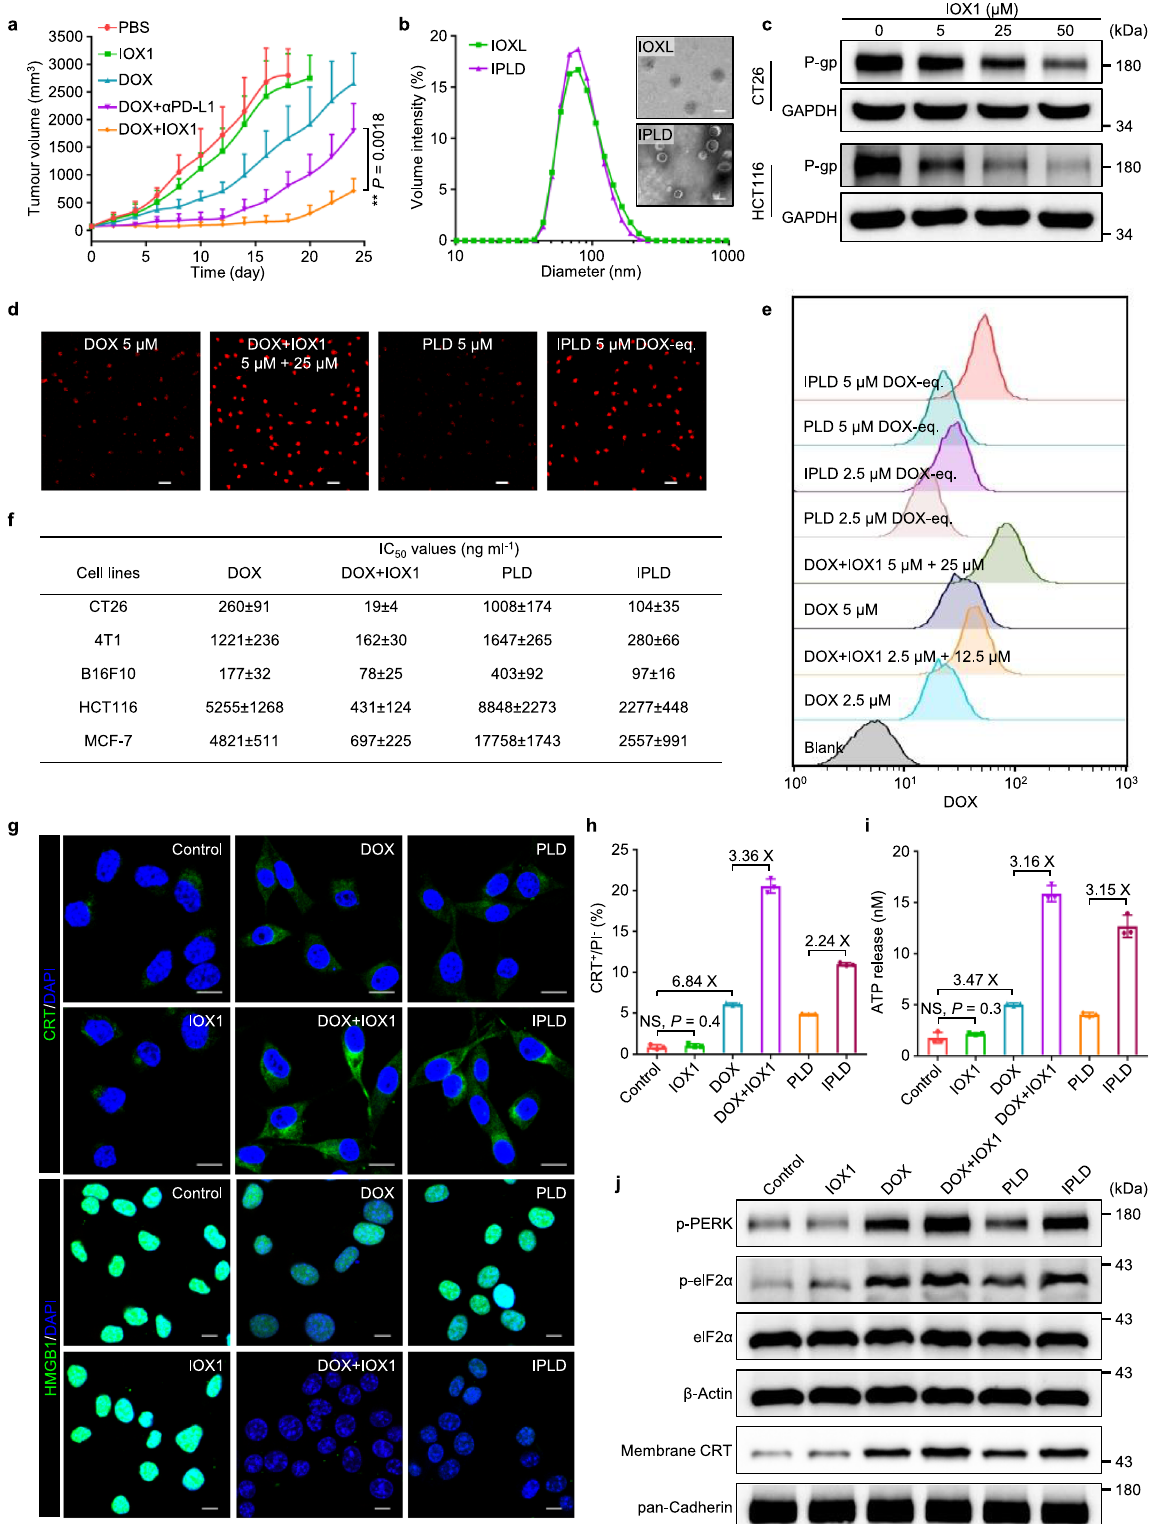
leading to cancer immunosuppressive microenvironment 1,7 . We found that IOX1 ef fi ciently downregulated the membrane PD-L1 in CT26 cells in a concentration-dependent manner (Fig. 3d; Supple- mentary Fig. 30). The PD-L1 expression of CT26 cells was reduced from 33.0% in control to 14.5% by 5 μ M IOX1 and even down to 9.9% by 25 μ M IOX1. This downregulation was further con fi rmed